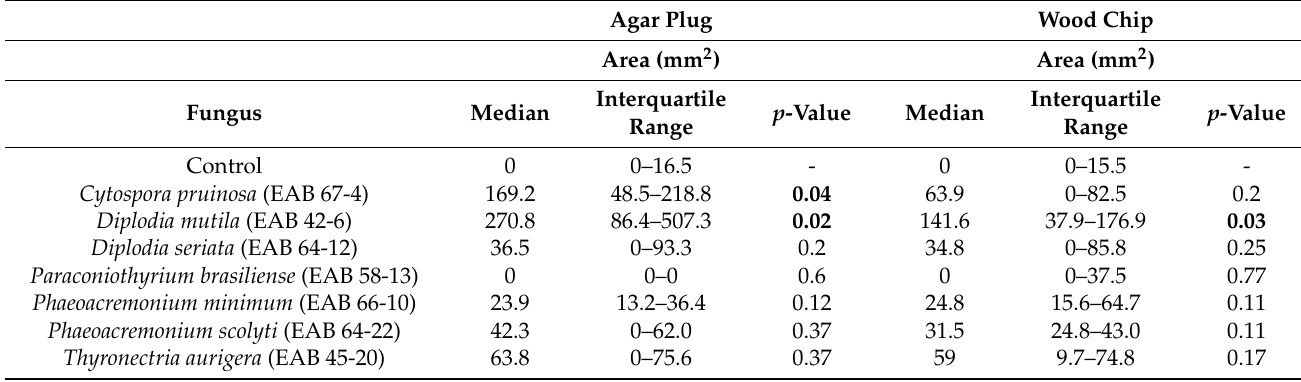
Table 2. Experiment 1 median canker area (mm 2 ) by treatment type and fungus. p -values were calculated by using Wilcoxon Rank Sum test. Treatments are being compared to the controls in each experiment. Significant results are shown in